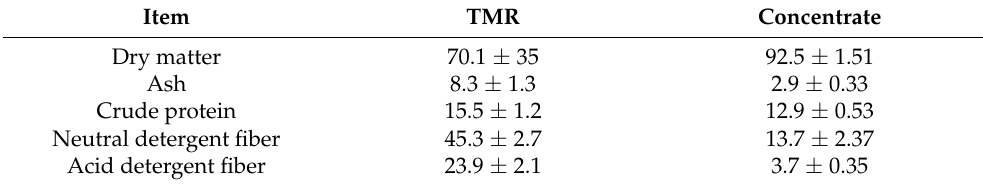
Table 2. Chemical compositions of the total mixed ration fed to dairy cows during the experiment.